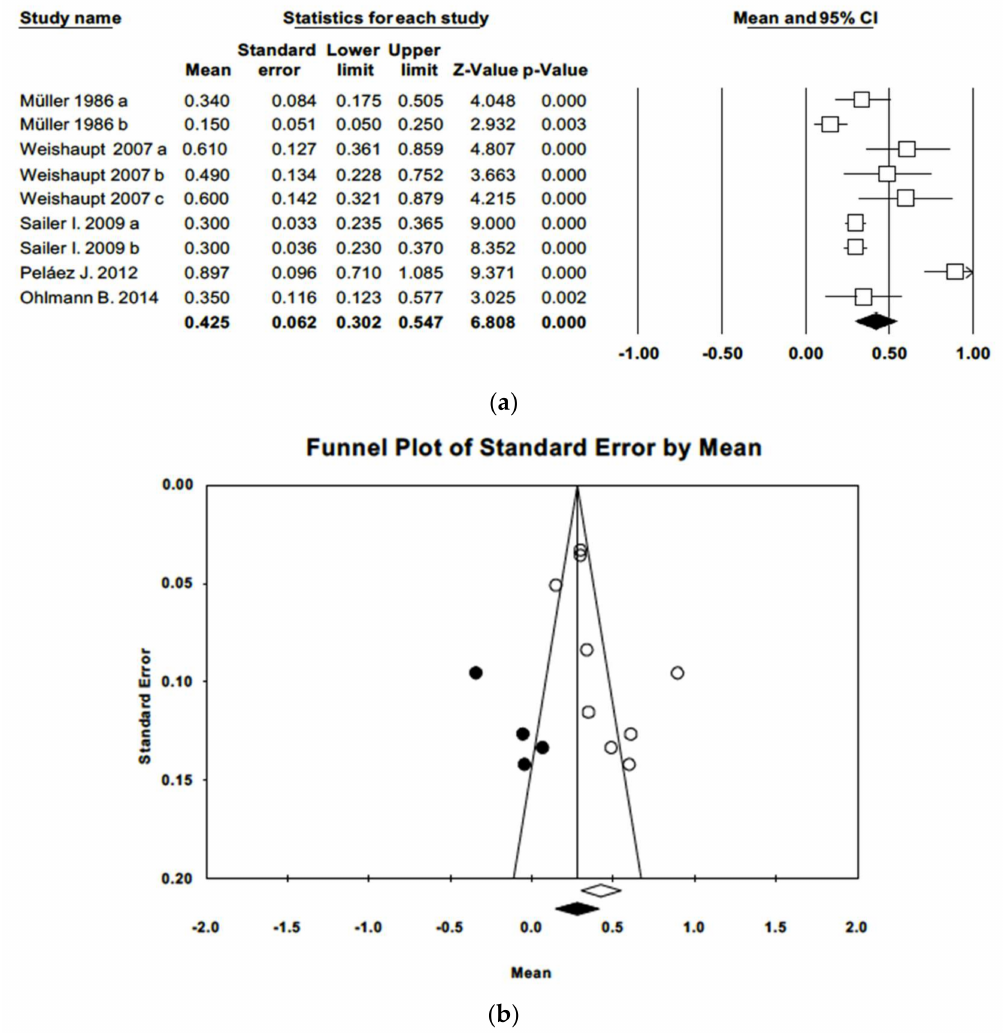
Figure 4. ( a ) Forest plot of gingival index meta-analysis. ( b ) Funnel plot of gingival index with observed and imputed